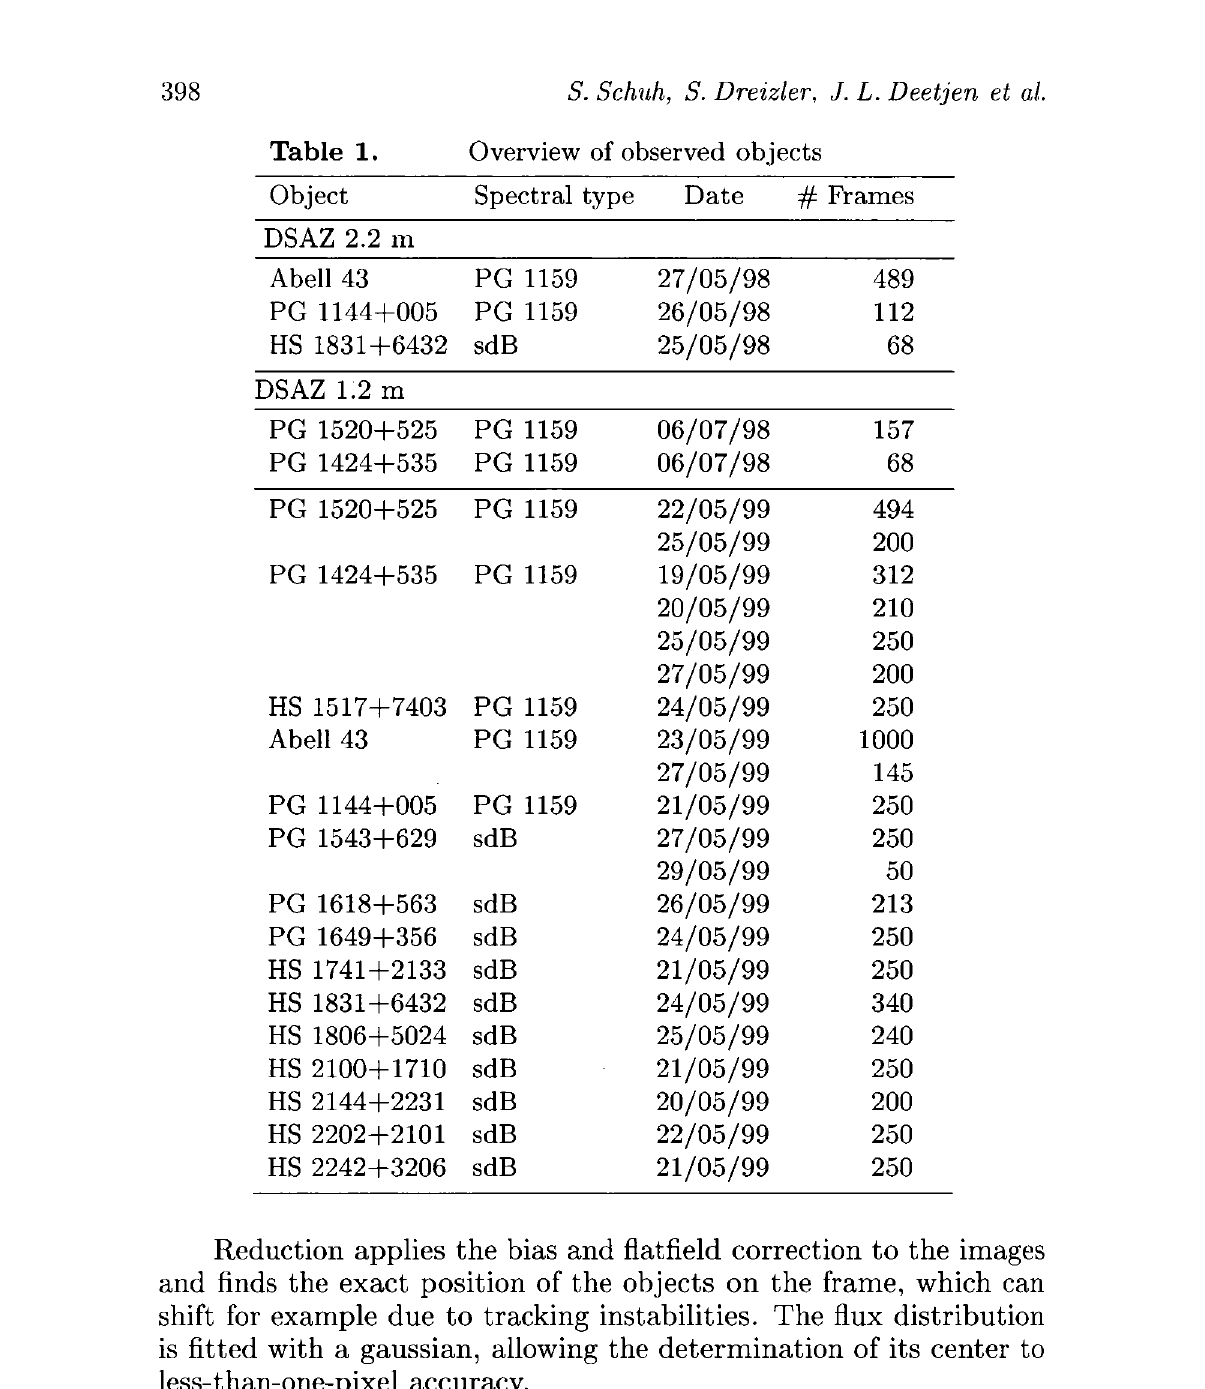
Overview of observed